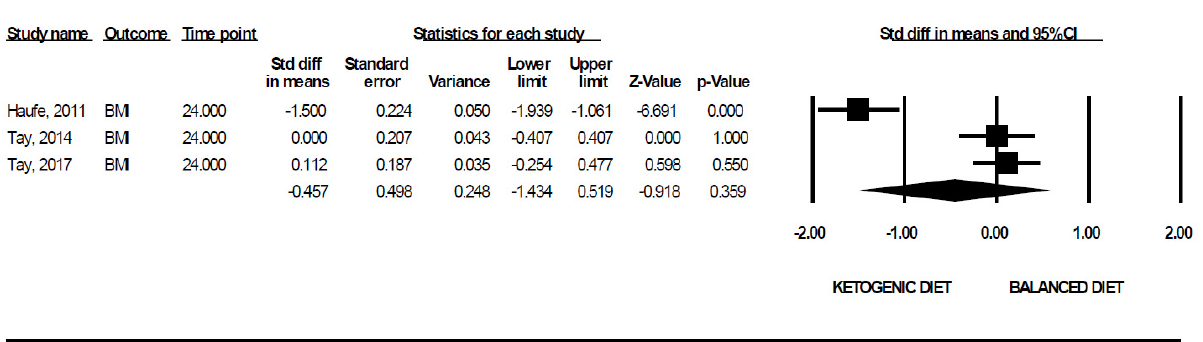
Figure 3. A forest plot of the effect of a ketogenic diet (KD) versus a balanced diet on body mass index (BMI), in kg/mt 2 .